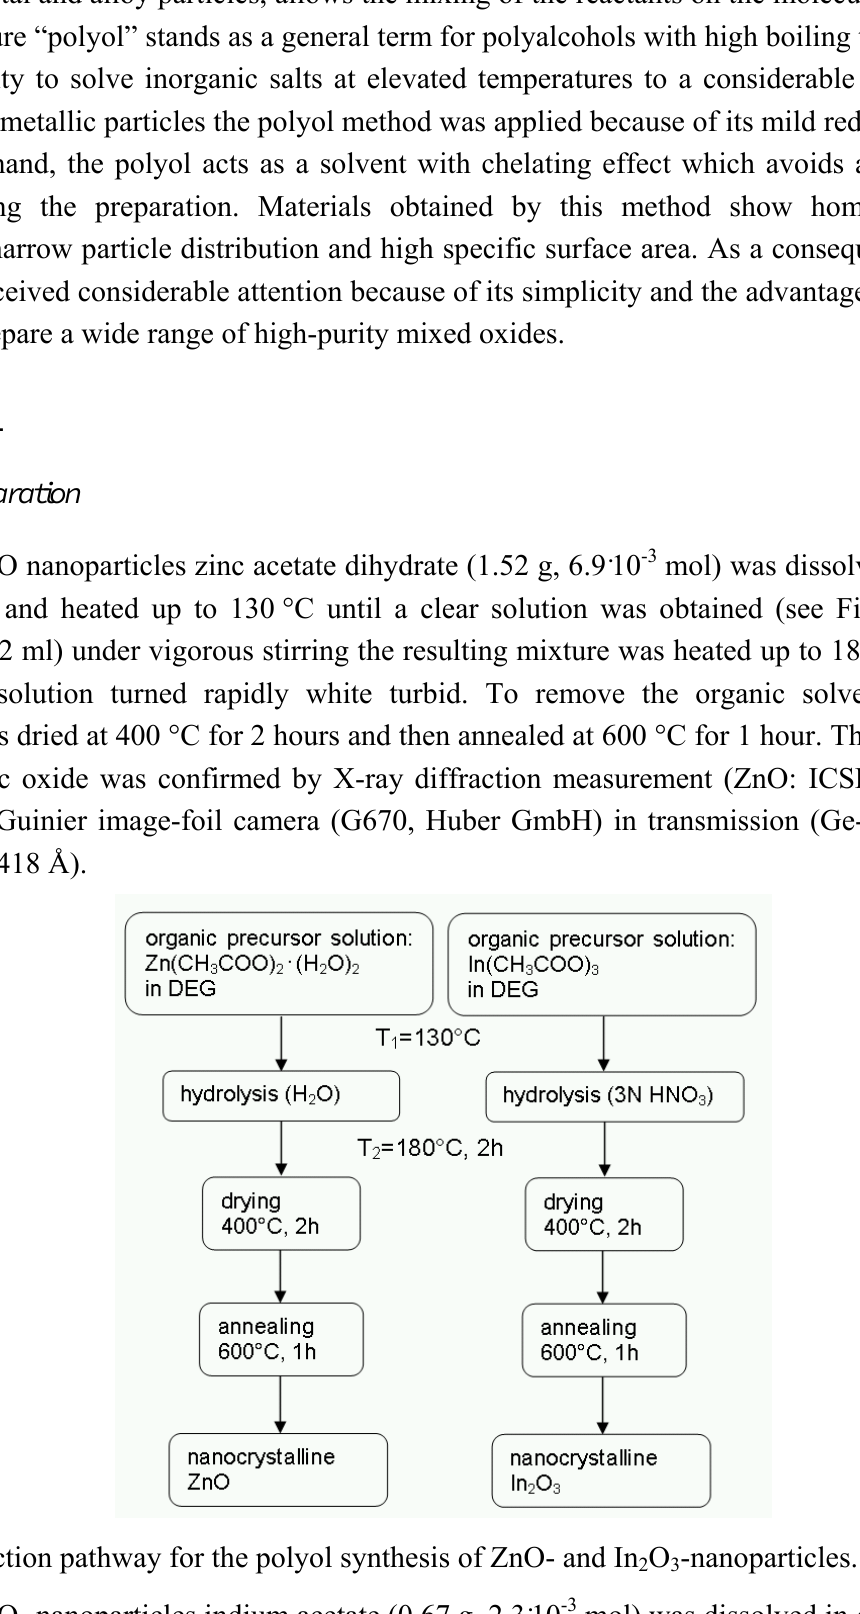
Figure 1. Reaction pathway for the polyol synthesis of ZnO- and In